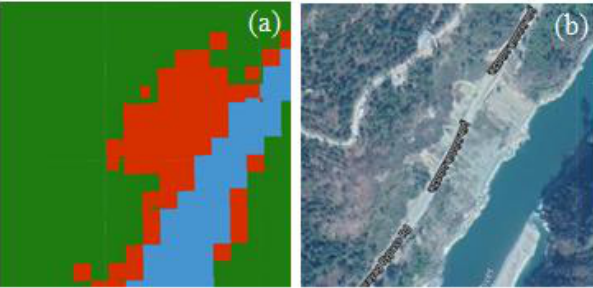
Figure 8. Location near Banadhar identified as